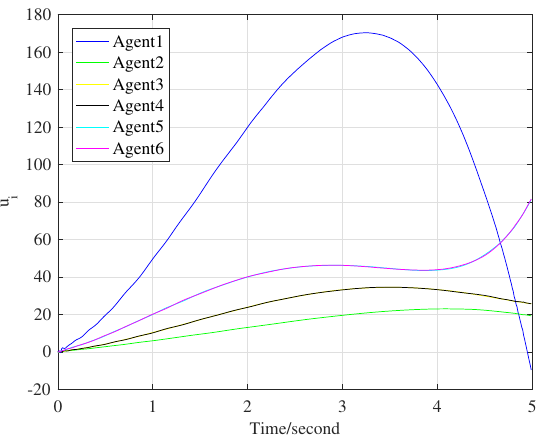
Figure 5. The control input signals at 70th